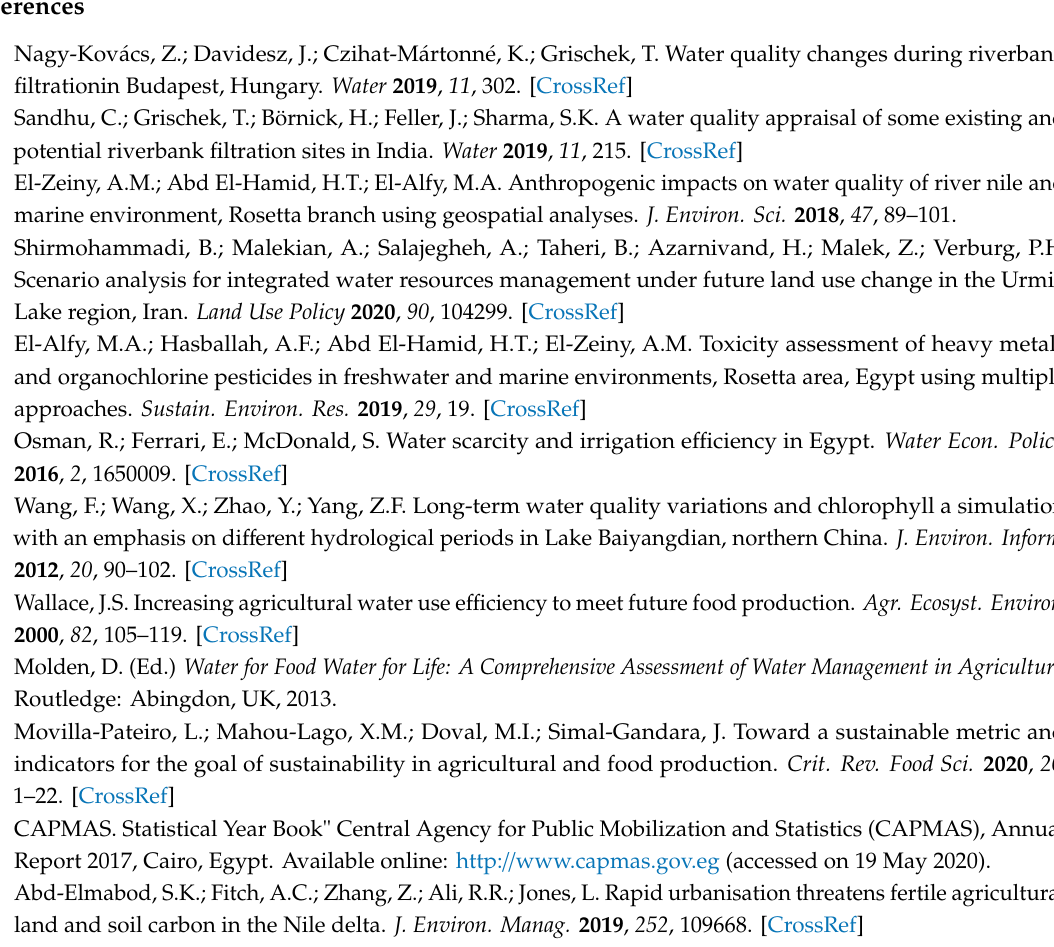
Figure S1: Impact of di ff erent land uses on irrigation water quality, Figure S2: The eigenvalue scree plot for determine the number of PCs in the analysis, Figure S3: Component loadings for the three PCs (A), PC scores for the three PCs (B), and PC comprehensive for the months (SX2), Table S1: Results of Kaiser–Meyer–Olkin (KMO) and Bartlett’s sphericity tests, Table S2: Annual average of chemical composition analysis of Bahr Mouise canal water, Table S3: Criteria for judging the validity of Bahr Mouise canal water, Table S4: Correlation components matrix; Table S5: The Class centroids and Central objects for each